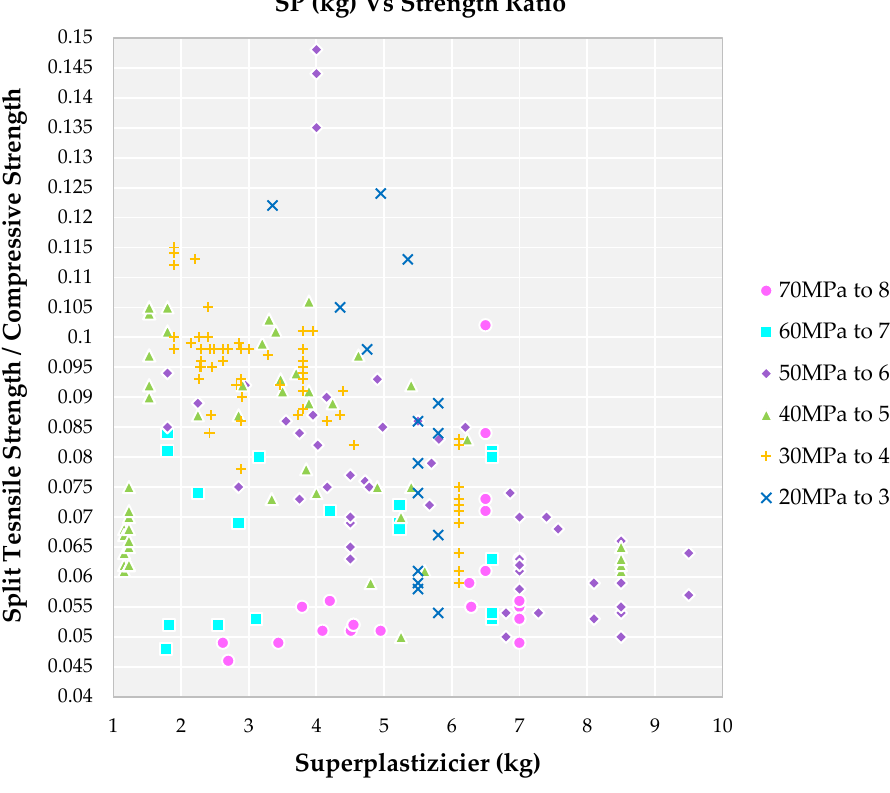
Figure 8. Impact of Superplasticizer weight on split tensile strength to compressive strength for different grades of SCC concrete with recycled aggregate according to literature.